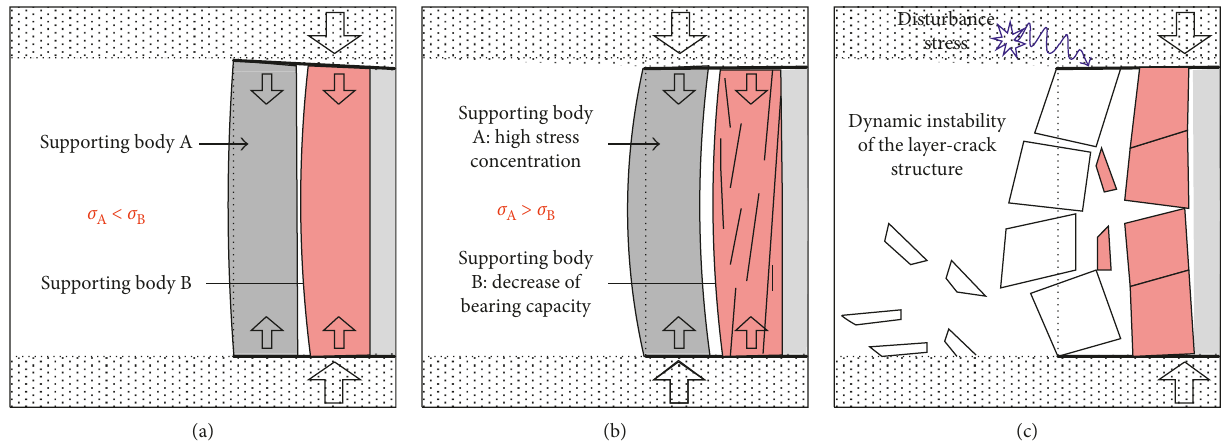
Figure 10: Schematic diagram of the failure mechanism of layer-crack structure: (a) under compression concentrating condition, (b) yield failure of supporting body B, and (c) dynamic instability of the whole layer-crack structure.